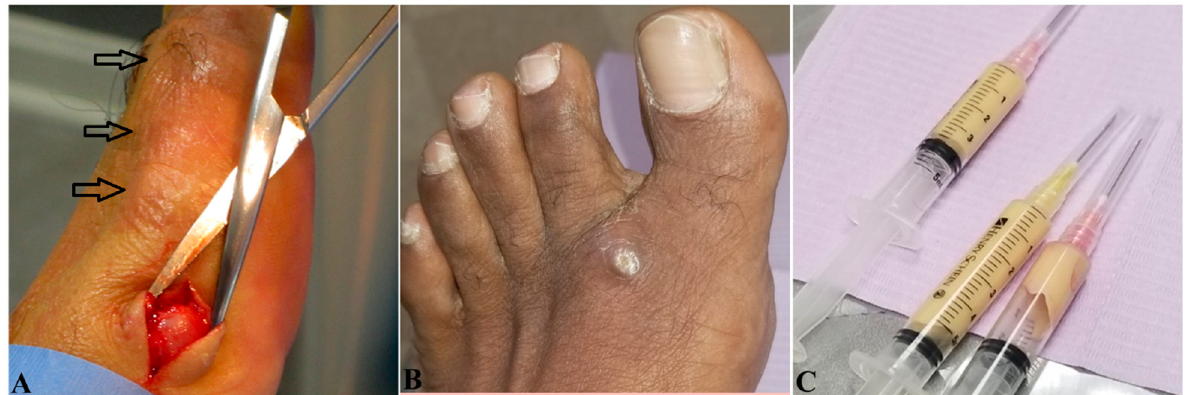
Figure 3. Clinical presentation of eumycetoma variants. ( A ) Multiple nodular eumycetomas without sinuses and discharge on the left dorsal interior foot in a 51-year-old male. ( B ) A 8.0 × 3.0 cm, giant, cystic eumycetoma in the first left intermetatarsal space in a 57-year-old male. ( C ) Thick, yellowish-whitish gelatinous liquid aspirated from ( B ).